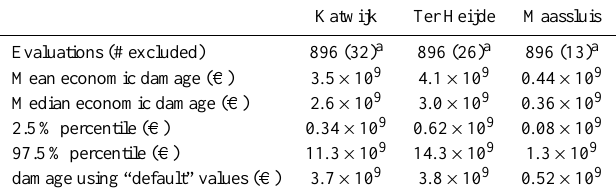
Table 4. Statistics of the damage calculations for the three locations in this